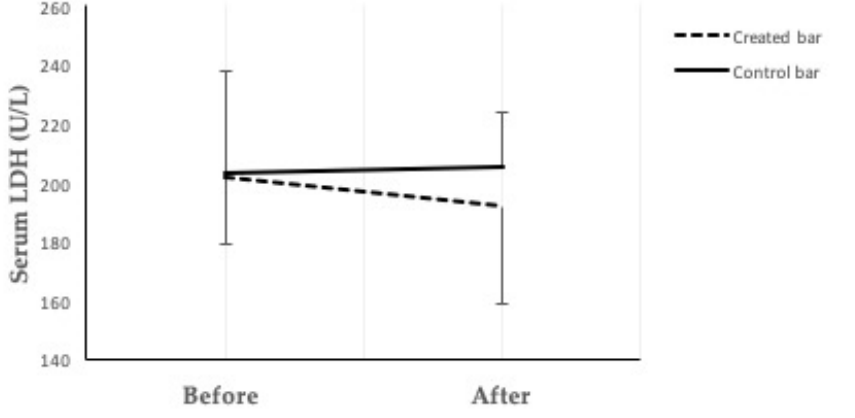
Figure 5. Serum LDH concentration before and after the created bar (dashed black lines) and the control bar (solid black lines) intake. Values are presented as means ± SD. Improvement in muscle mass and exercise performance, fat loss, and improvement in recovery biomarkers are the basic health benefits result from protein supplement con- sumption [28]. During prolonged or high-intensity exercise, cell membrane permeability is increased, and various enzymes, including AST and LDH, may be released, indicating mus- cle damage [29]. The present 5-day long pilot study demonstrated the short-term effects of the created high-protein bar consumption on AST and LDH serum marker reduction, i.e., its potential to protect athletes’ exercise-induced muscle